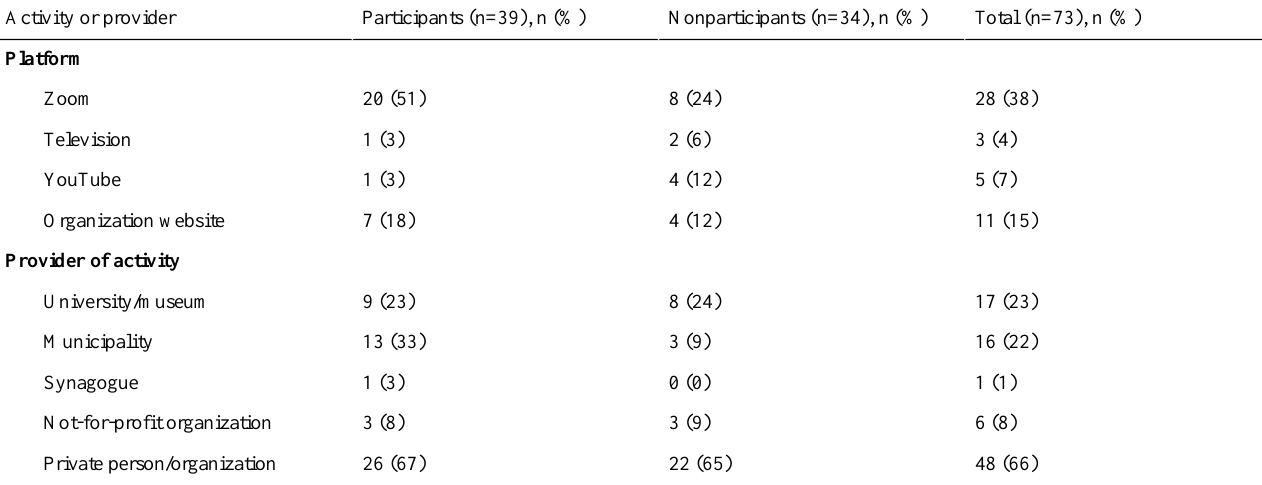
Table 5. Characteristics of the alternative activities engaged in by the study participants (n=73).